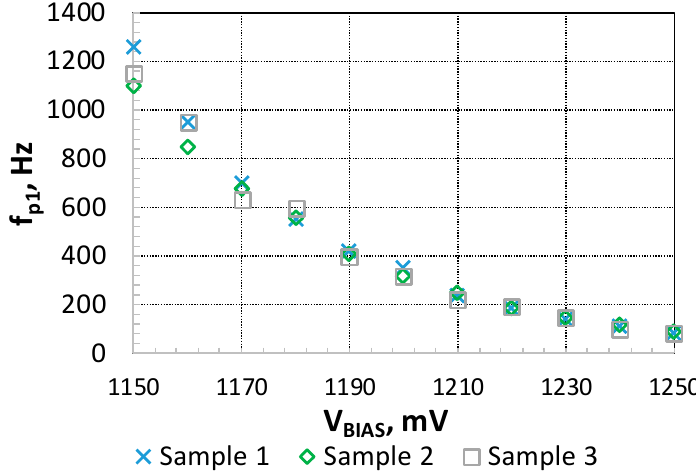
Figure 7. f p 1 as a function of V BIAS . Measurements performed in three different samples.